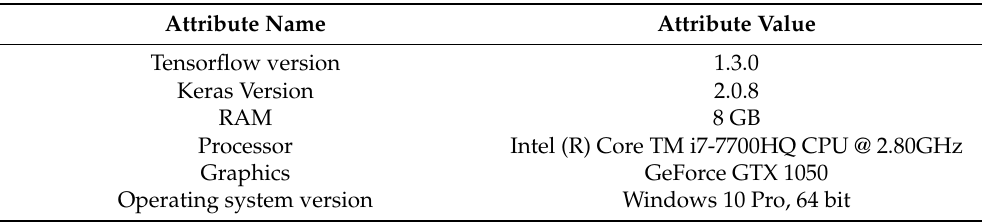
Table 3. Experimental environmental information.